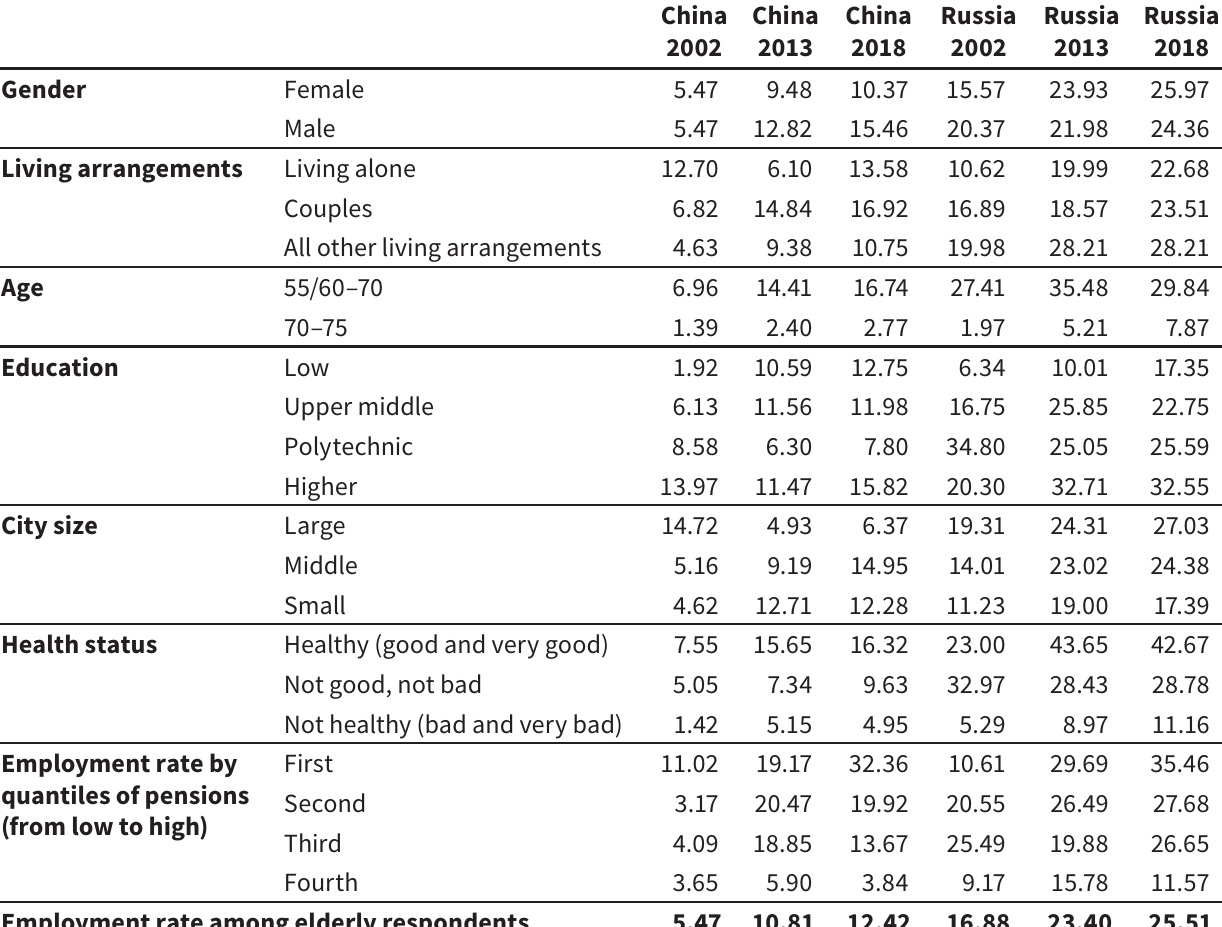
Employment rates for older people in urban China and urban Russia in 2002, 2013, and 2018